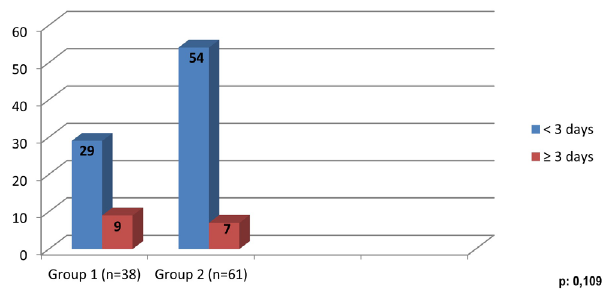
and rewarming period. The right pulmonary artery incision should be initiated by the medial side of the superior vena cava. A microtome knife (Jamieson dissector) is used in the posterior dissecting